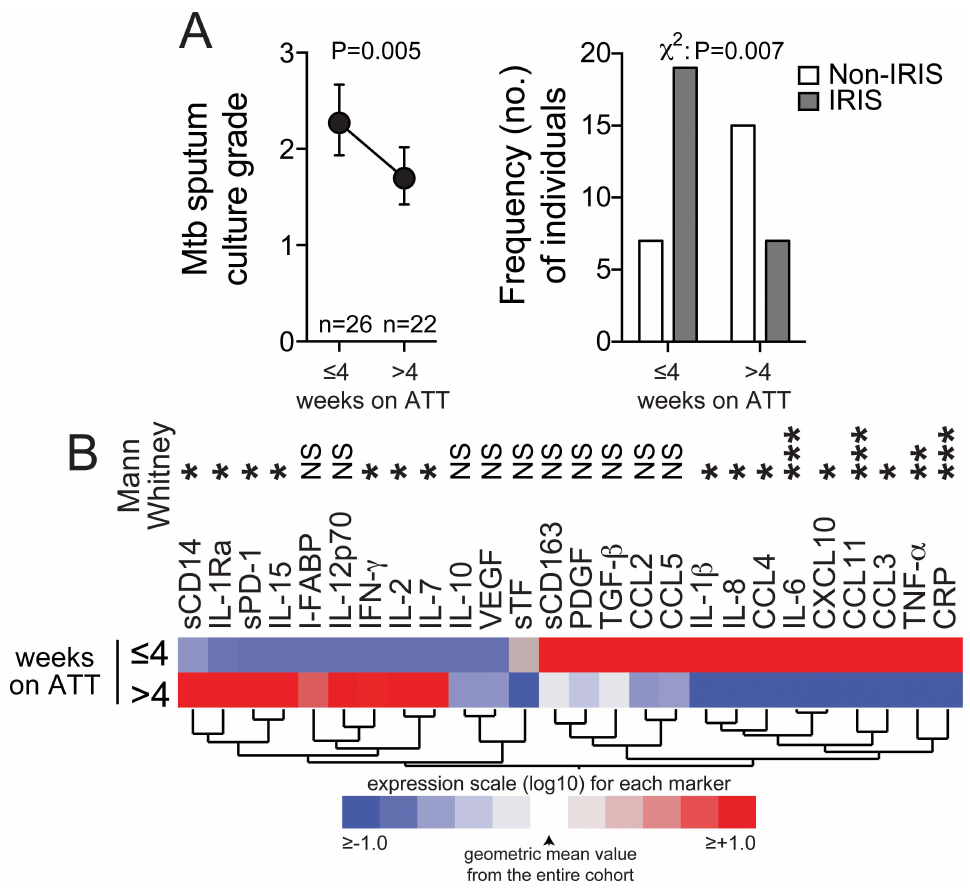
Figure 2. Expression profile of plasma biomarkers of inflammation and immune activation in TB-HIV co-infected patients on anti- TB therapy. ( A ) Left panel shows Mycobacterium tuberculosis sputum culture grade in samples from TB-HIV co-infected individuals at study enrollment (pre-ART) stratified by time on anti-TB treatment (ATT). Data were compared using the Mann-Whitney test. Right panel shows the frequency of IRIS vs. non-IRIS patients taking ATT for different durations ( # 4 weeks and . 4 weeks). Data were compared using the Chi-square test. ( B ) A heat map was designed to depict the overall pattern of expression of plasma cytokines, chemokines and inflammatory biomarkers in TB-HIV co- infected patients at different time points after ATT initiation. A hierarchical cluster analysis (Ward’s method) of circulating biomarkers by clinical group and time point was performed. Expression scale for each biomarker represents change from the geometric mean of the entire study population (n=48). Differences between medians were compared using the Mann-Whitney test. * P , 0.05, ** P , 0.01, *** P ,